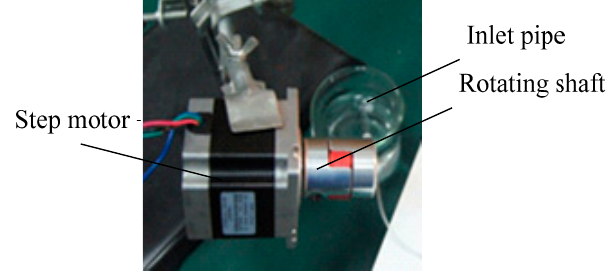
Figure 7. Manually adding bubble device.